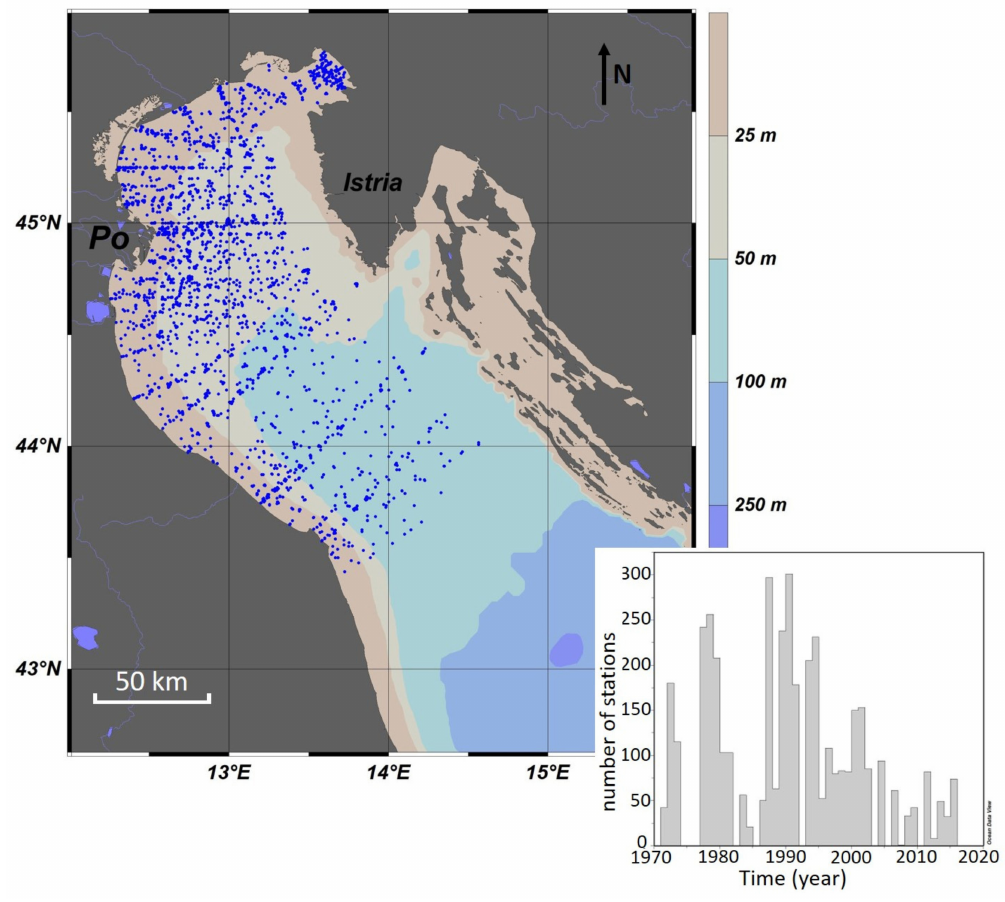
Figure 1. Geographical distribution of sampling stations and number of stations per year (inset) collected from 1971 to